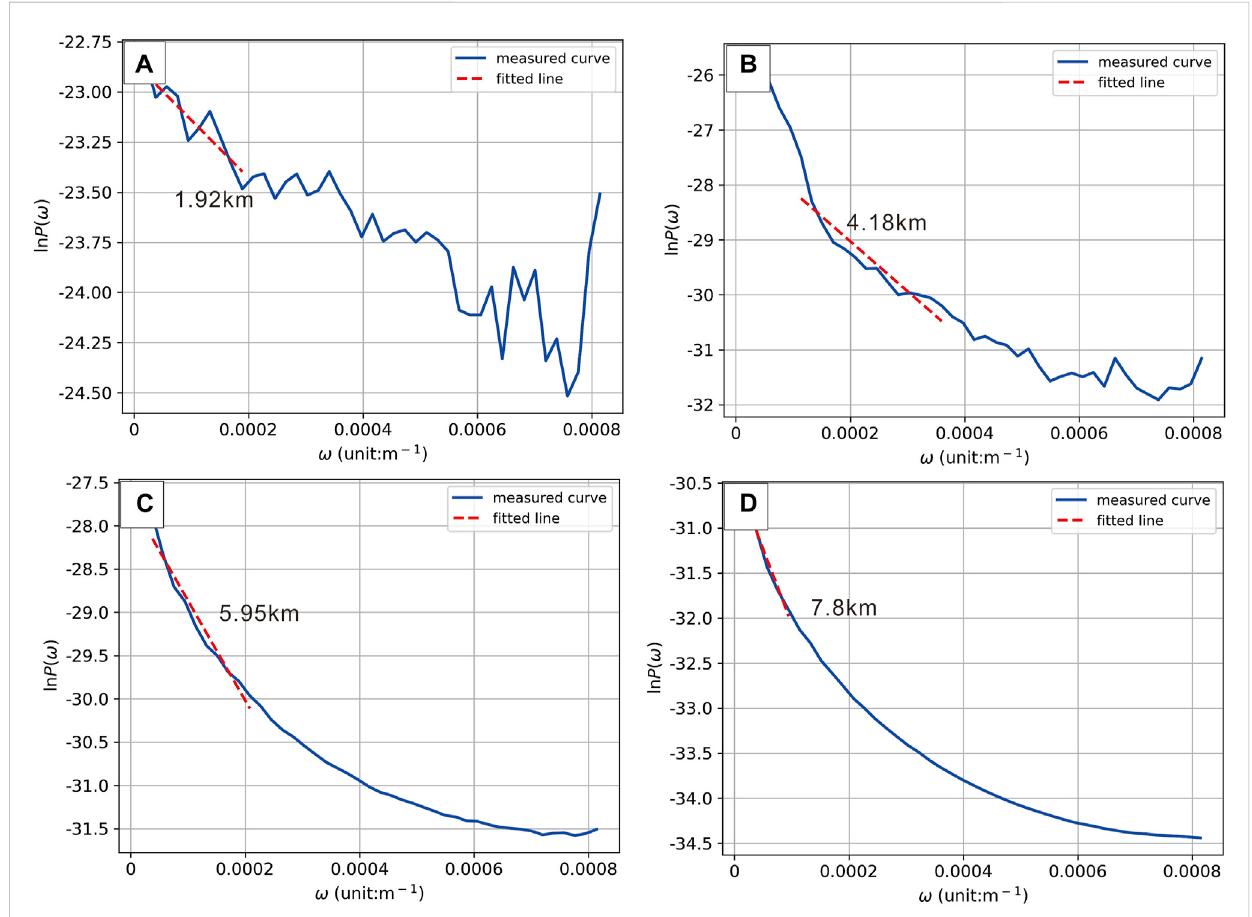
FIGURE 6 Estimated depths of BIMFs and RES decomposed from RTP anomaly: (A) BIMF M1 (B) BIMF M2 ; (C) BIMF M3 (D) RES M .